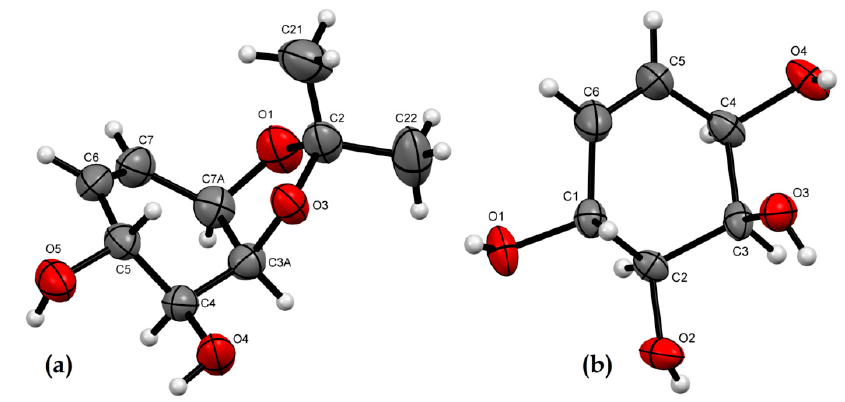
Scheme 4. Synthesis of ( − )-conduritol C.